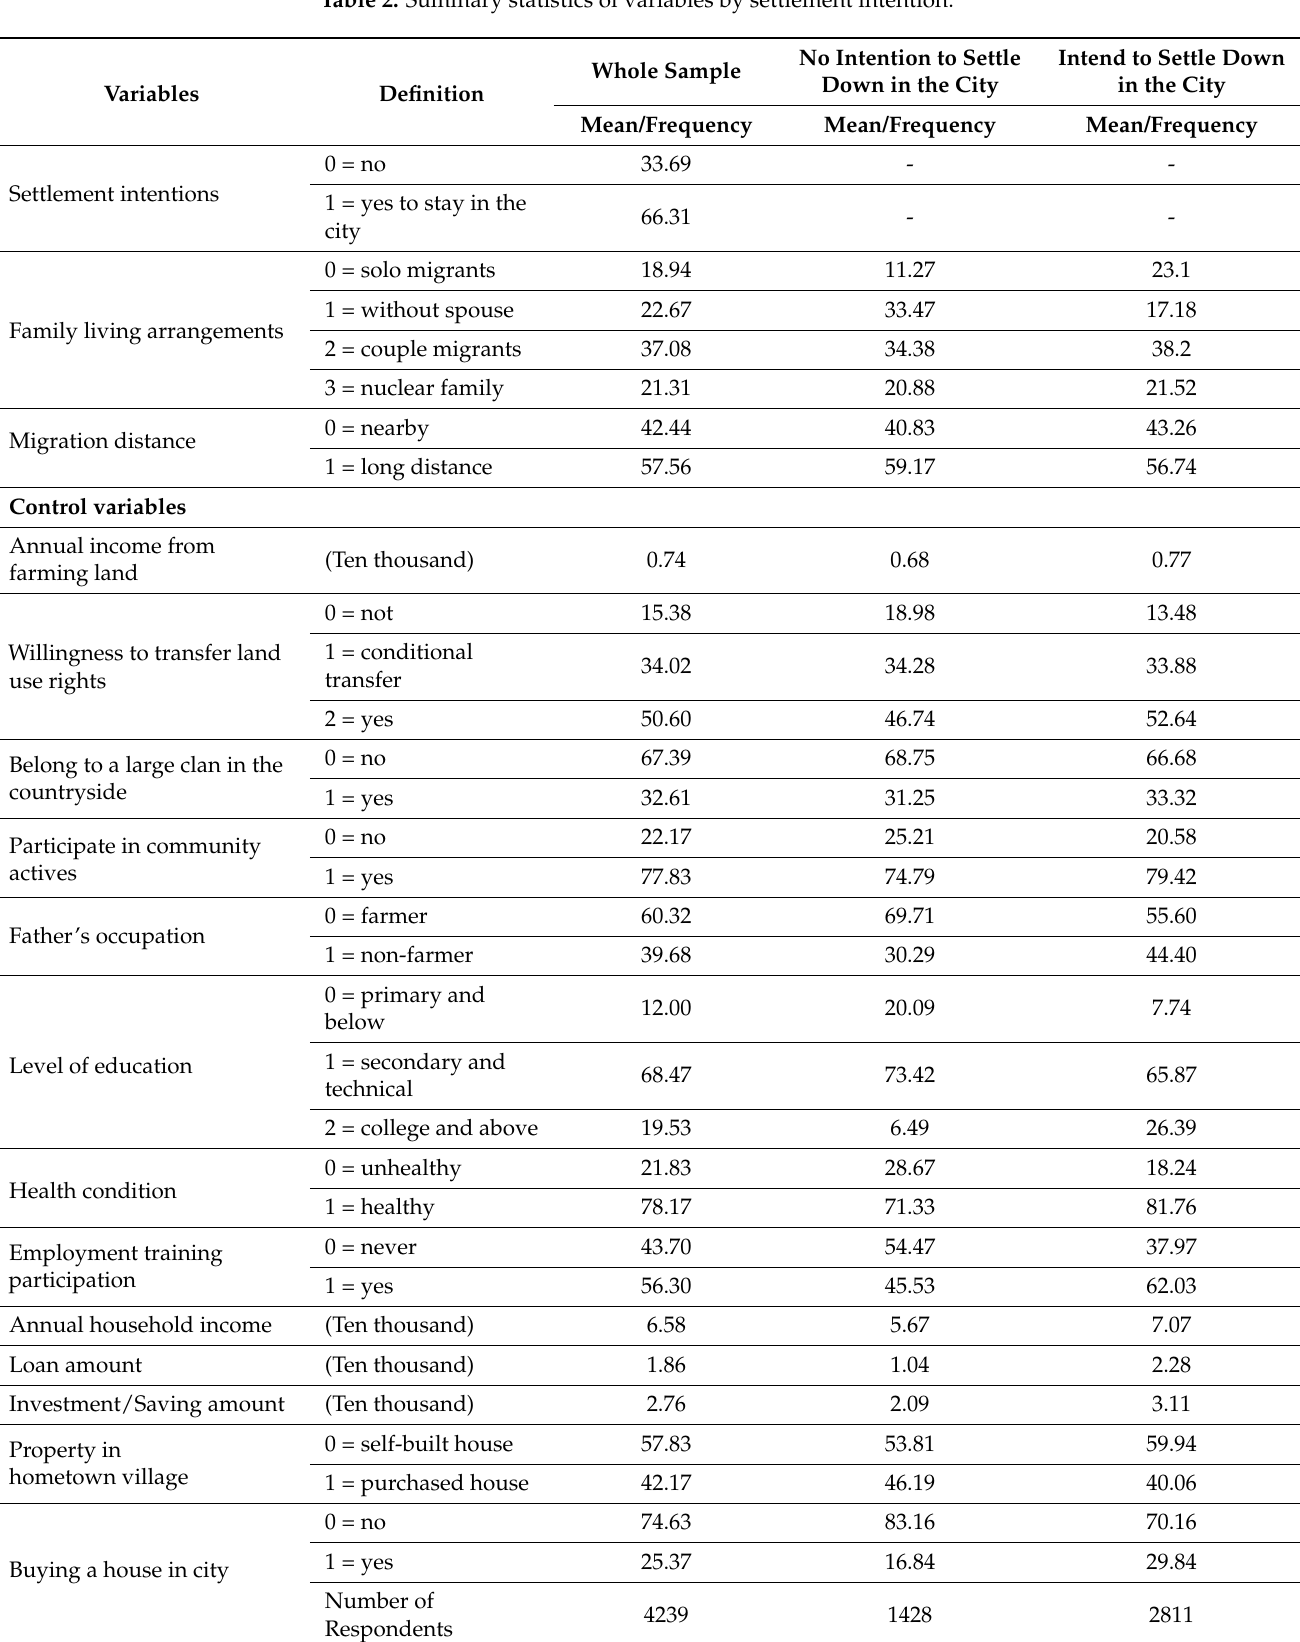
Table 2. Summary statistics of variables by settlement